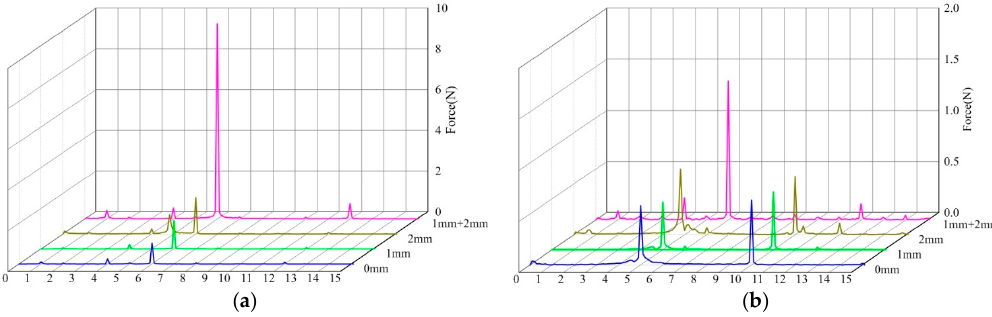
Figure 11. Frequency domain of radial force on hub and blade suction side: ( a ) Radial force spectral on hub and ( b ) Radial force spectral on blade suction side.